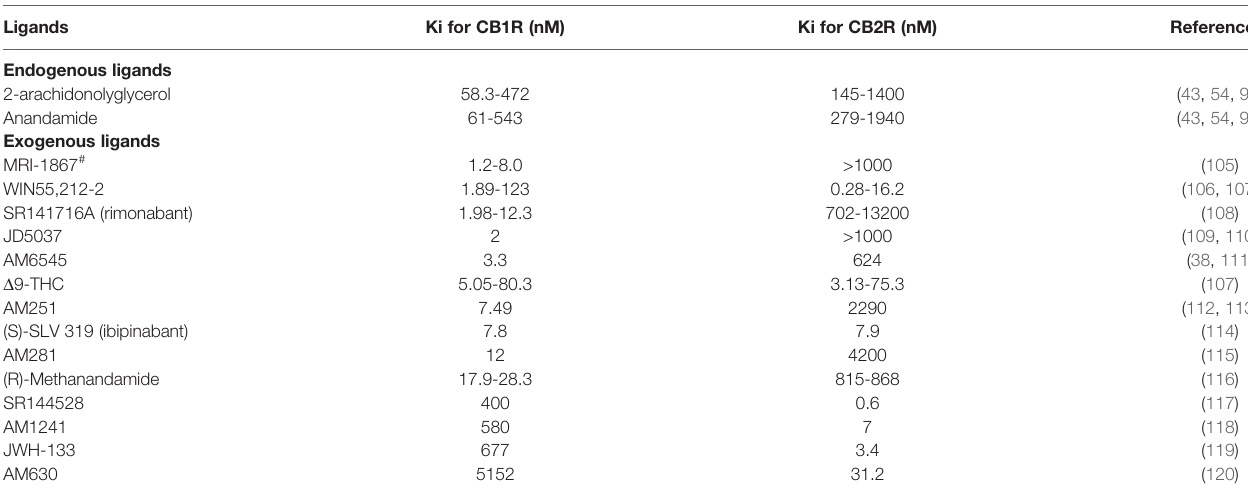
TABLE 2 | Af fi nity of ligands for CB1R and CB2R.